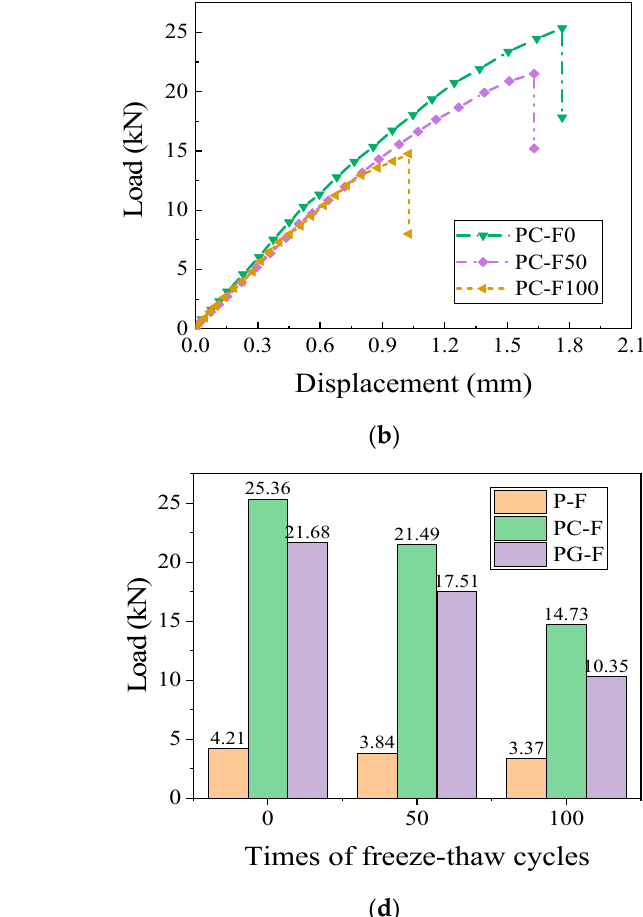
Figure 9. Load displacement curve of prismatic specimen: ( a ) unreinforced prism; ( b ) carbon- fiber-strengthened prism; ( c ) glass-fiber-strengthened prism; ( d ) stress variation with respect to freeze–thaw